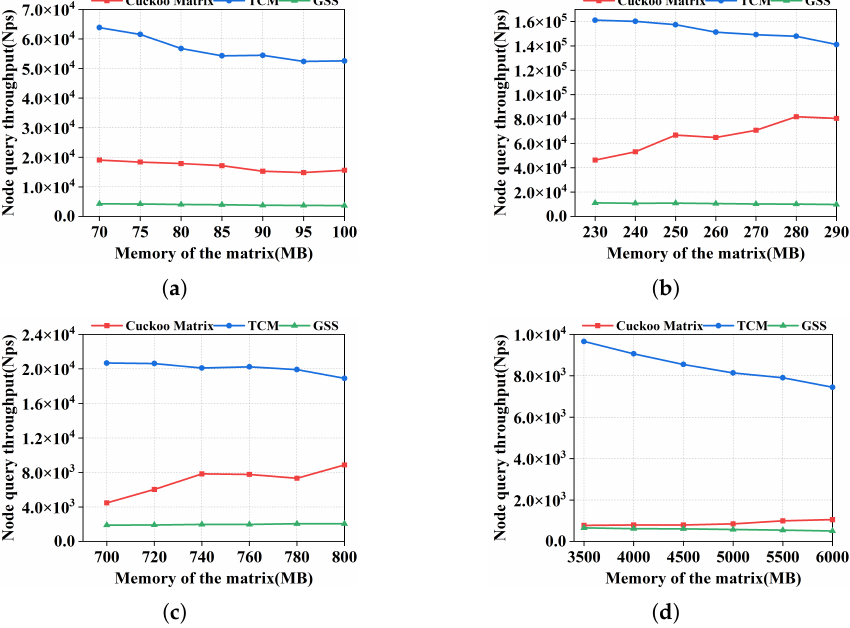
Figure 7. Throughput of node queries. ( a ) Skitter. ( b ) DBLP. ( c ) Orkut. ( d )